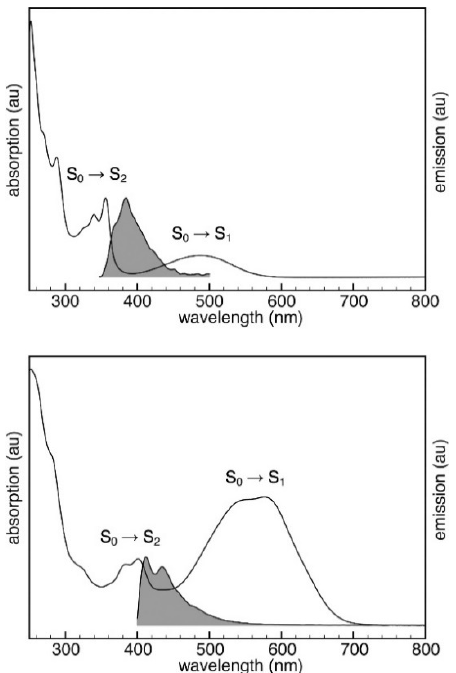
Figure 19. Absorption (white) and emission (gray) features for 71 ( top ) and 72 ( bottom ) in DCM. Reprinted with permission from [71], Copyright 2014, American Chemical Society.